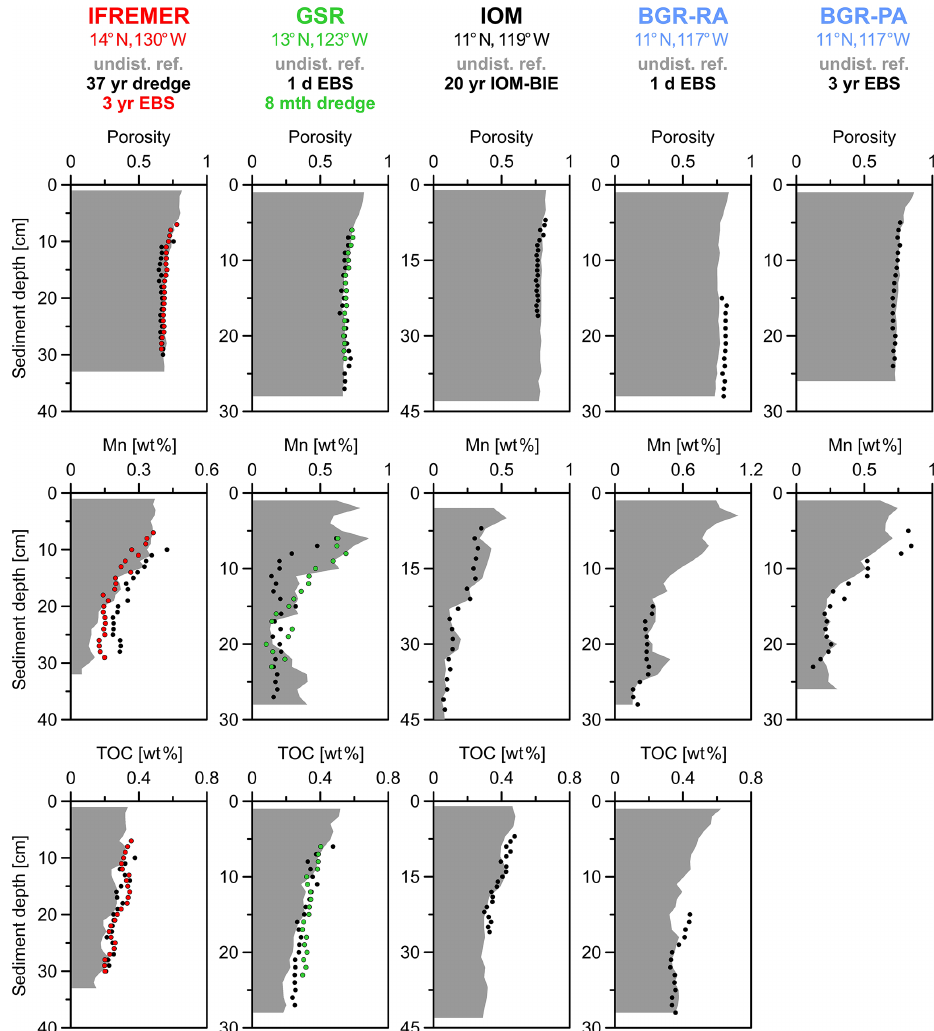
Figure 4. Correlation of solid-phase Mn and TOC contents between the disturbed sites and the respective undisturbed reference sediments (grey shaded profiles) using the disturbance depths determined with the Pearson correlation coefficient (compare Table 3). For the undisturbed reference sediments, solid-phase Mn contents are taken from Volz et al. (2020) and TOC contents are taken from Volz et al. (2018; years: yr; months: mth; days: